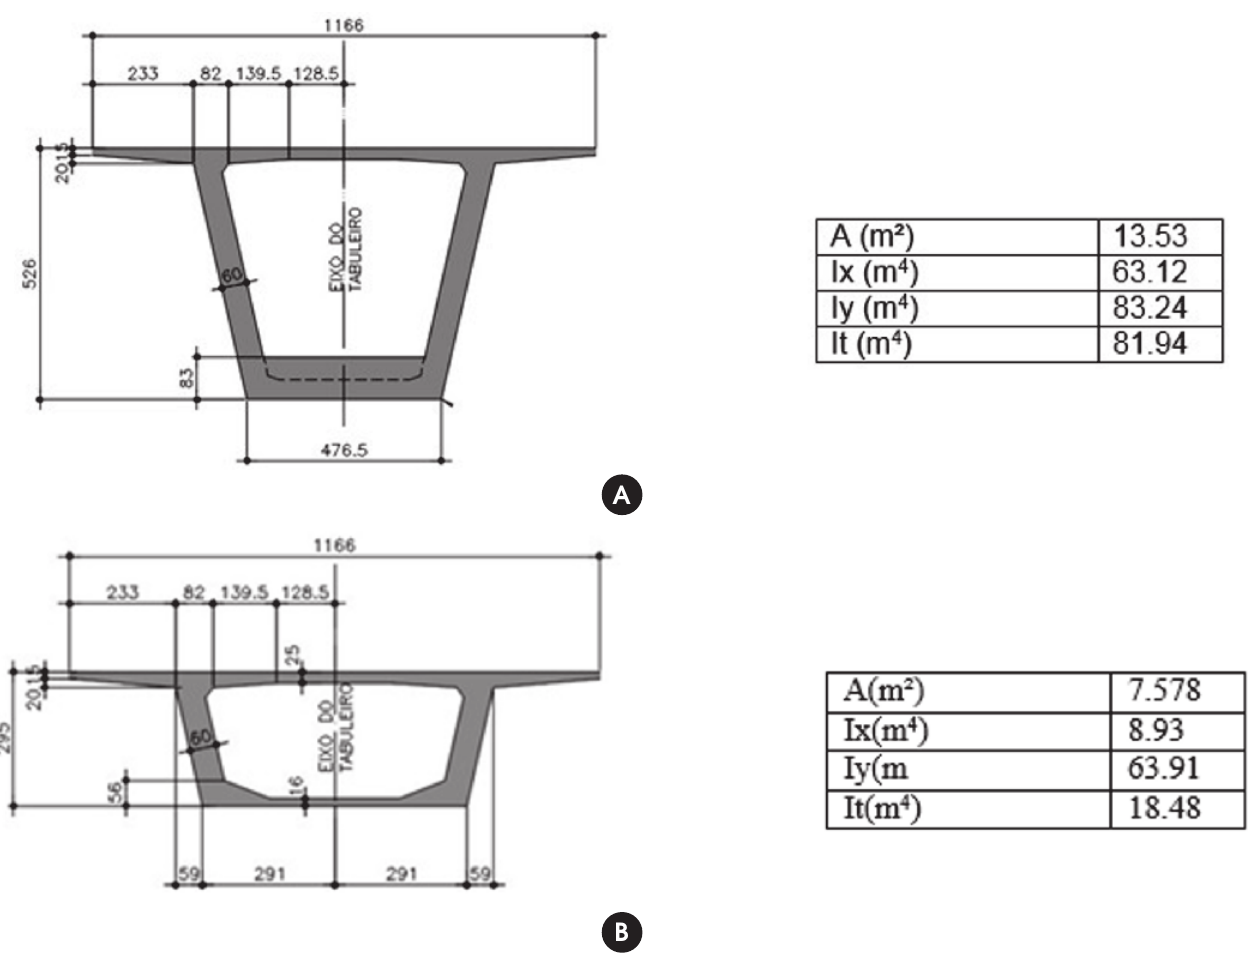
Dimensions and properties of the cross-sections: (a) at the support (b) at the middle of the span (drawing supplied by EGT